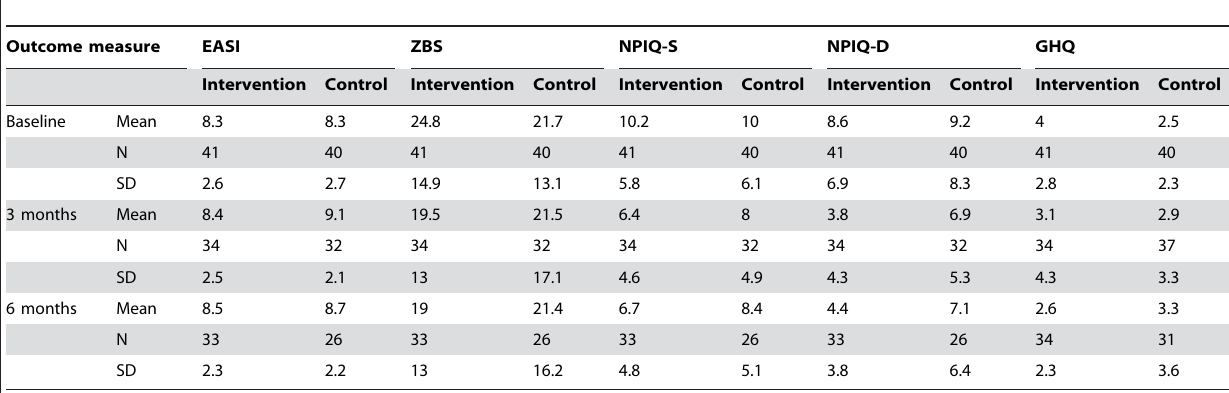
Table 2. Outcome measures at baseline and review in a sample of dyads of persons with dementia and caregivers in a RCT of a community intervention for dementia in Goa,